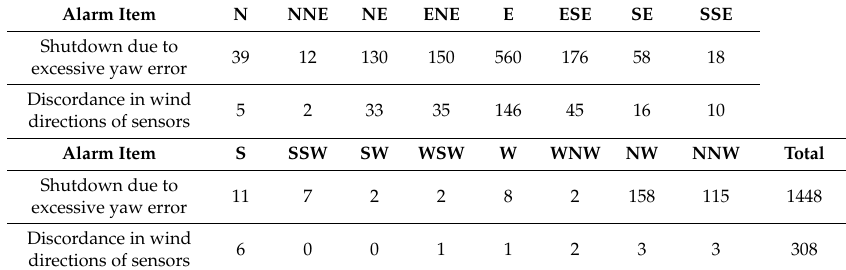
Table 3. Number of alarm occurrences due to wind conditions for each wind direction.